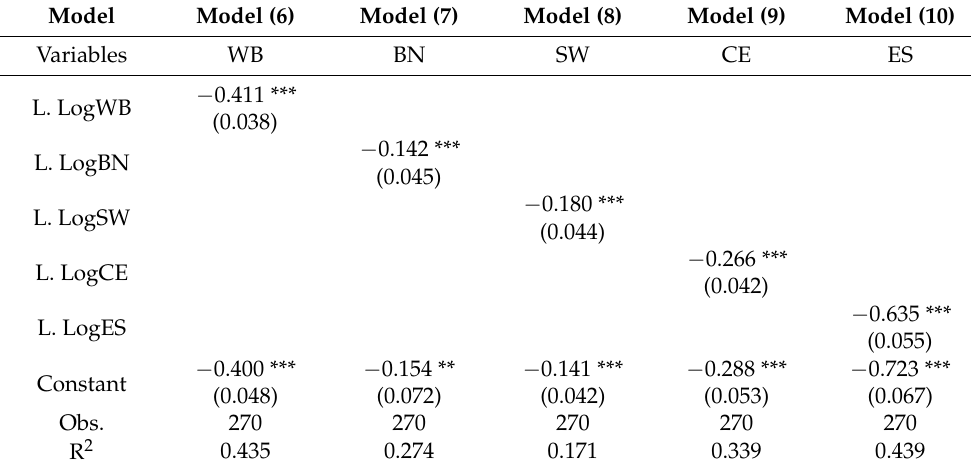
Table 3. Results of conditional β convergence models.